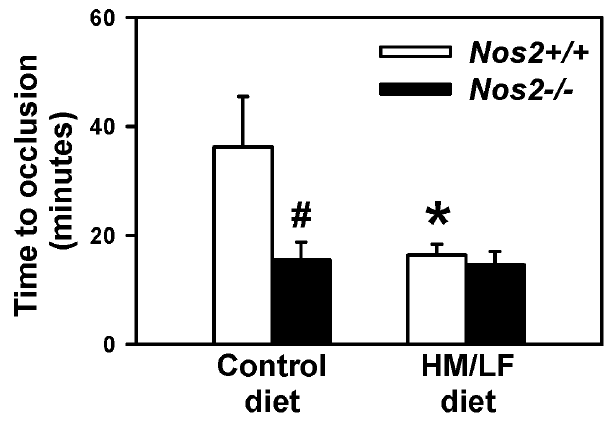
Figure 3. Carotid artery thrombosis. The time to stable occlusion of the carotid artery in Nos2 + / + (open bars) or Nos2 2 / 2 (filled bars) mice fed either the control diet or the HM/LF diet was measured following photochemical injury. 6–8 mice were studied in each group. *P , 0.05 compared with mice of the same genotype fed the control diet; # P , 0.01 compared with Nos2 + / + mice fed the same diet by two- way ANOVA.